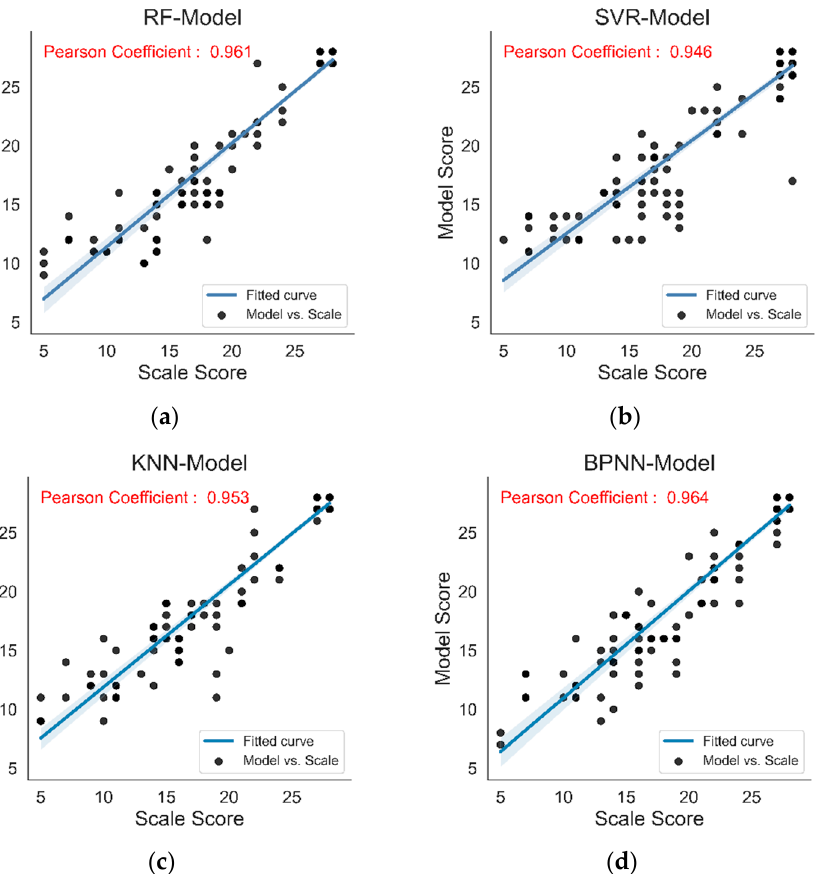
Figure 8. Pearson correlation analysis of the prediction score of four evaluation models and the